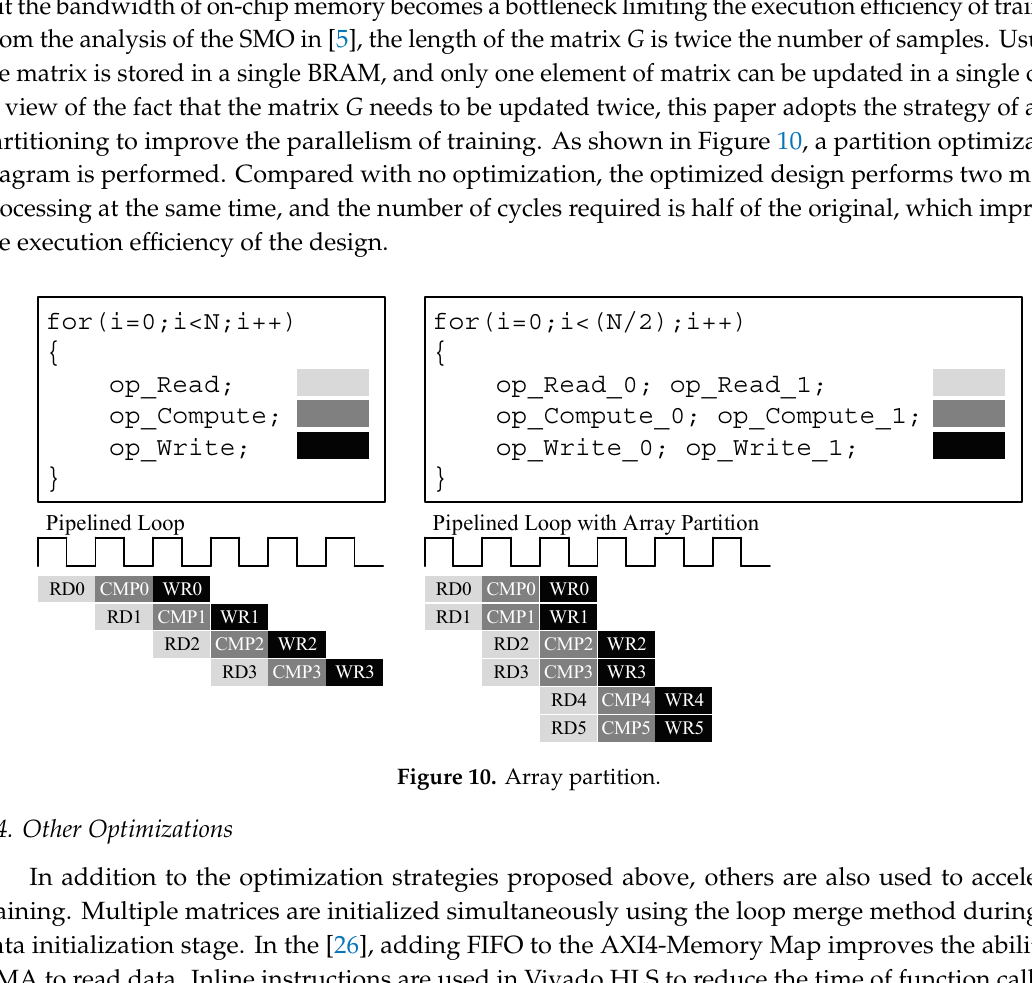
Figure 9. Loop pipelining with rewind.